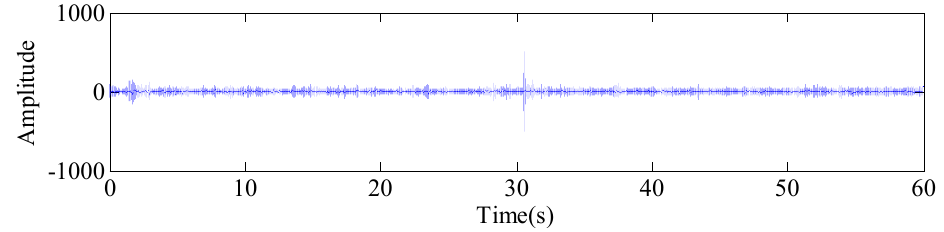
Figure 19. Time domain vibration signal of axle box bearing.